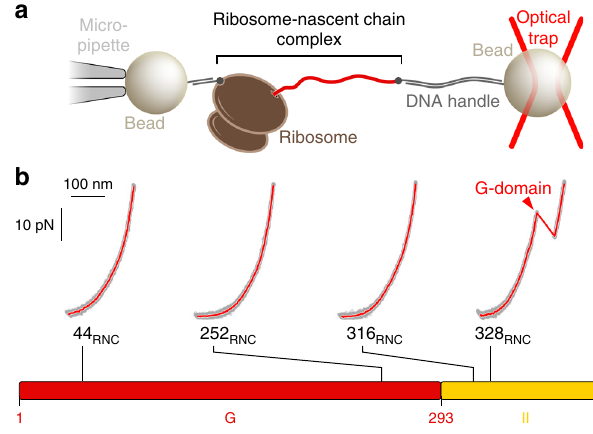
Fig. 5 Nascent chain structure probed with single-molecule force spectroscopy. a Cartoon schematic (not to scale) of the experimental setup. A single ribosome-nascent chain complex (RNC) is tethered between two polystyrene beads by means of DNA handles. Moving the bead held in the optical trap enables application of force to nascent EF-G polypeptides. b Representative force-extension curves of RNCs with four distinct lengths (gray dots: raw data, 1000Hz; red lines: fi ltered data, 30 Hz). When the G-domain is fully outside the ribosome (328 RNC ), the characteristic unfolding transition of the G-domain is observed (red arrowhead). Shorter chain lengths (44 RNC , 252 RNC , 316 RNC ) do not show de fi ned unfolding transitions. The bar diagram at the bottom indicates the positions of the chain lengths in the EF-G primary